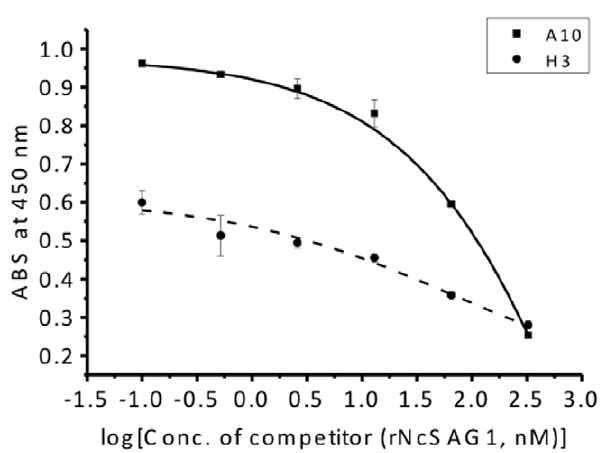
Figure 2. The half maximal inhibitory concentration of A10 and H3 to rNcSAG1. rNcSAG1 solutions with serially diluted concentration were used to inhibit the binding of Fab-phage of A10 and H3 to immobilized rNcSAG1 on a microplate. The IC 50 of both clones was evaluated to be 50 and 72 nM of rNcSAG1 based on the dose-response curve (n=3).